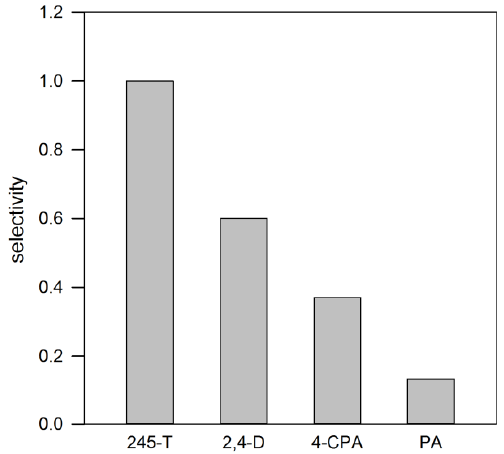
Figure 4. Selectivity (α) and change of Gibbs free energy (ΔΔG) of 2,4,5-T-imprinted capillary measured towards phenoxyacetic acid (PA), 4-chlorophenoxyacetic acid (4-CPA), and 2,4- dichlorophenoxyacetic acid (2,4-D) by using 50% v / v acetonitrile added to 5 mmol∙L −1 phosphate buffer, pH 2.0.